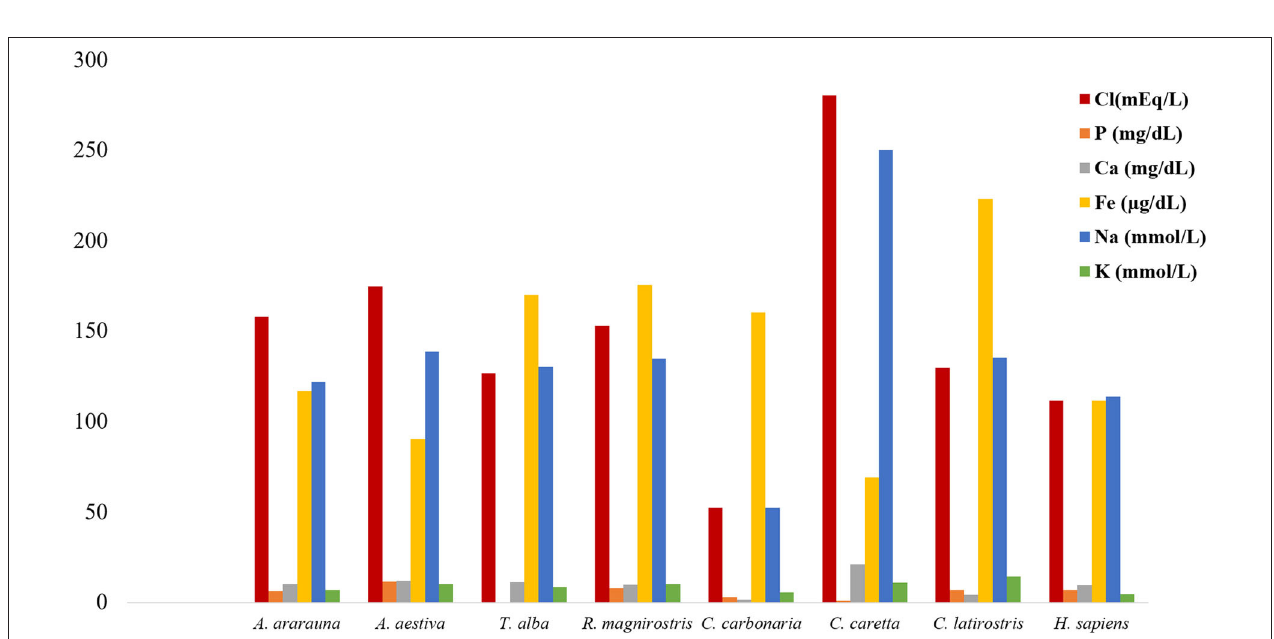
FIGURE 3 | Amount of electrolytes in tears of birds, reptiles, and humans. Note increased chloride, iron, and sodium contents in tears of all species.